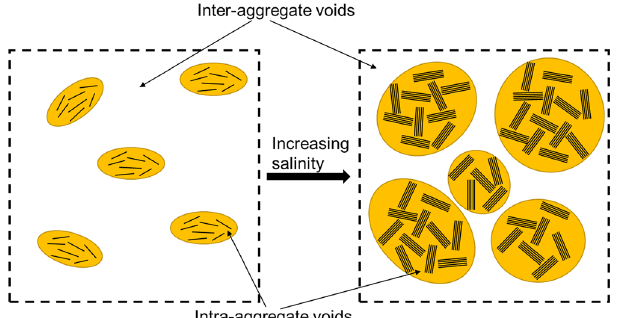
Figure 14. Conceptual representation unit of soft marine clay.